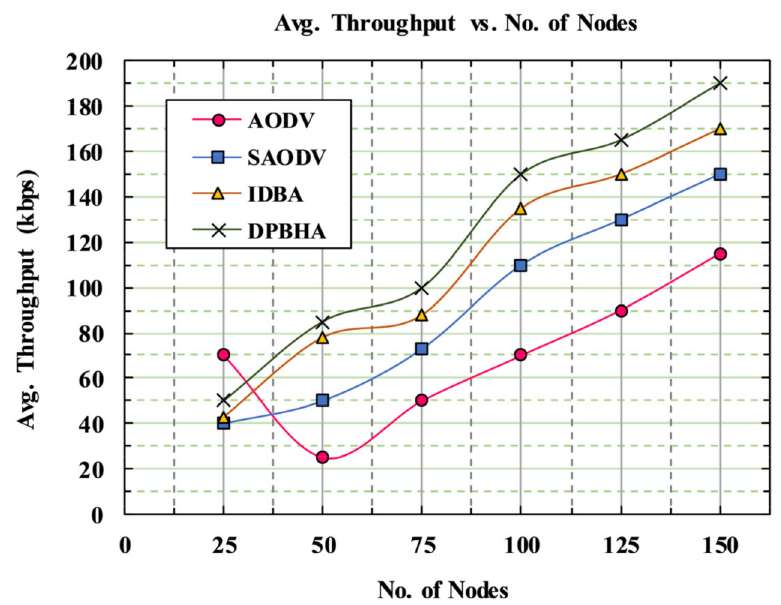
Figure 12. Graphical representation of average